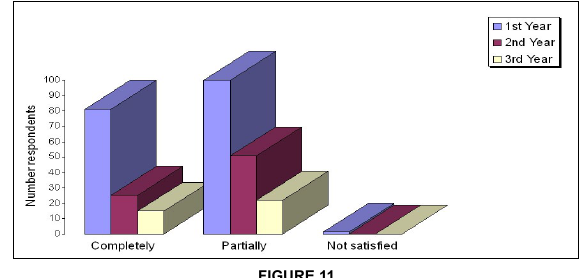
FIGURE 11 Information needs satisfaction via search